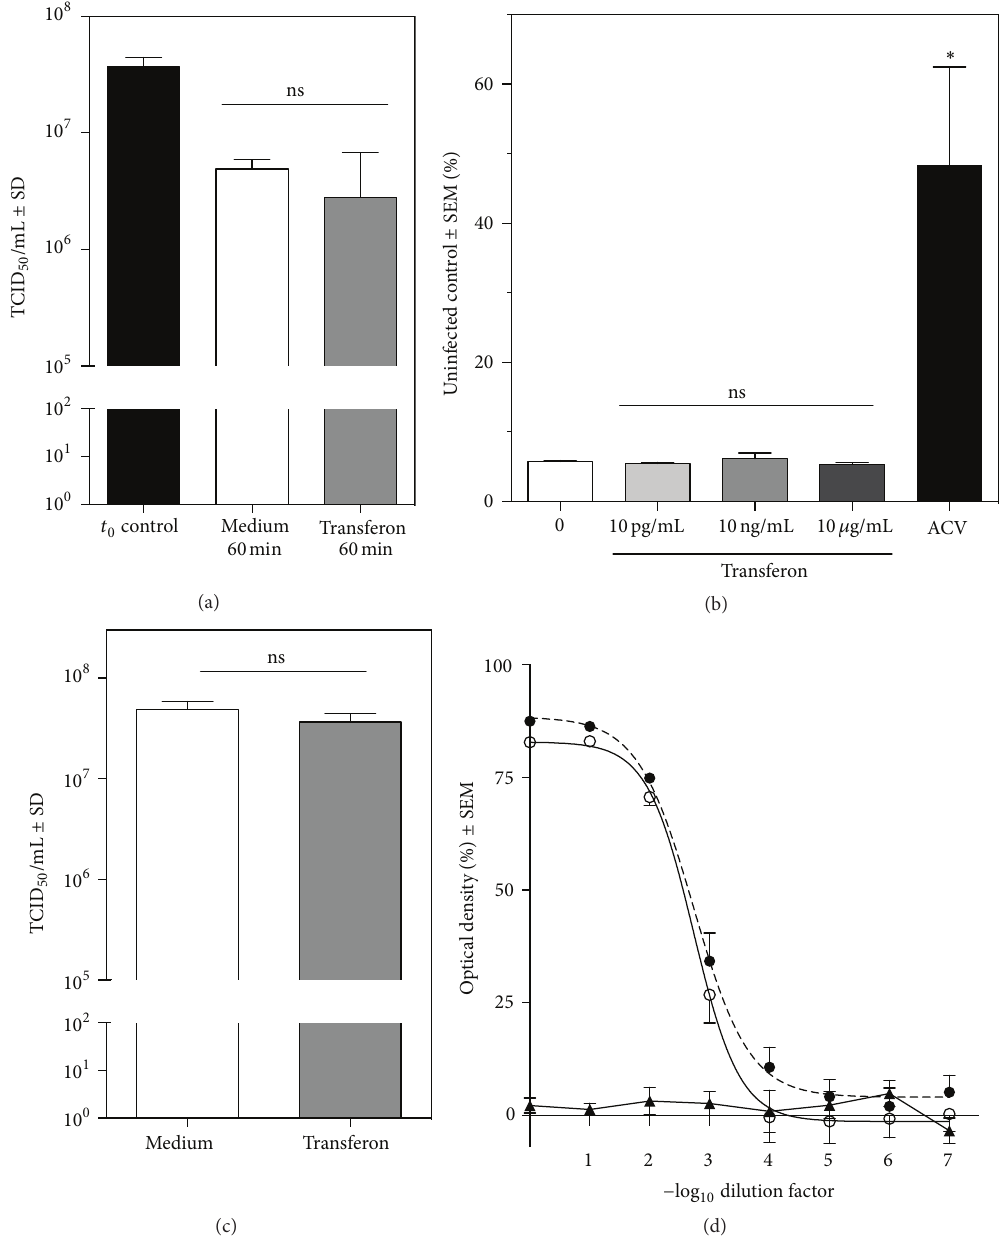
Figure 4: In vitro evaluation of antiviral activity of Transferon. (a) HSV-1 was preincubated for 60 min with Transferon (20 𝜇 g/mL) or medium before evaluation of visible cytopathic effect (CPE) on Vero cells. Viruses with no preincubation ( t 0 ) were used as control (ANOVA, Bonferroni’s Multiple Comparison Test; ns: nonsignificant). (b) Effect of Transferon (10pg/mL–10 𝜇 g/mL) on HSV-1-induced